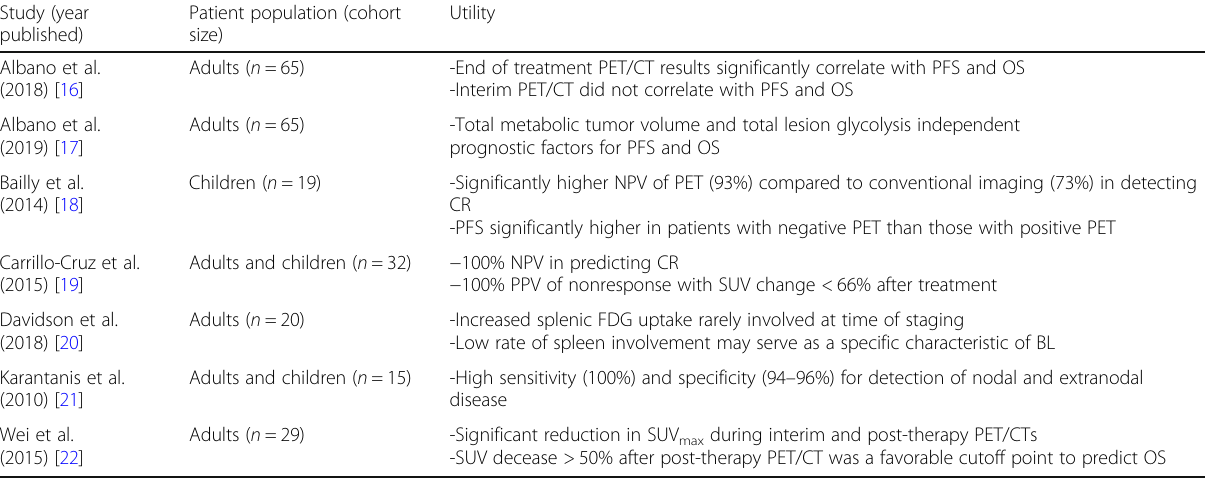
Table 1 Utility of PET in Burkitt lymphoma Study (year published)